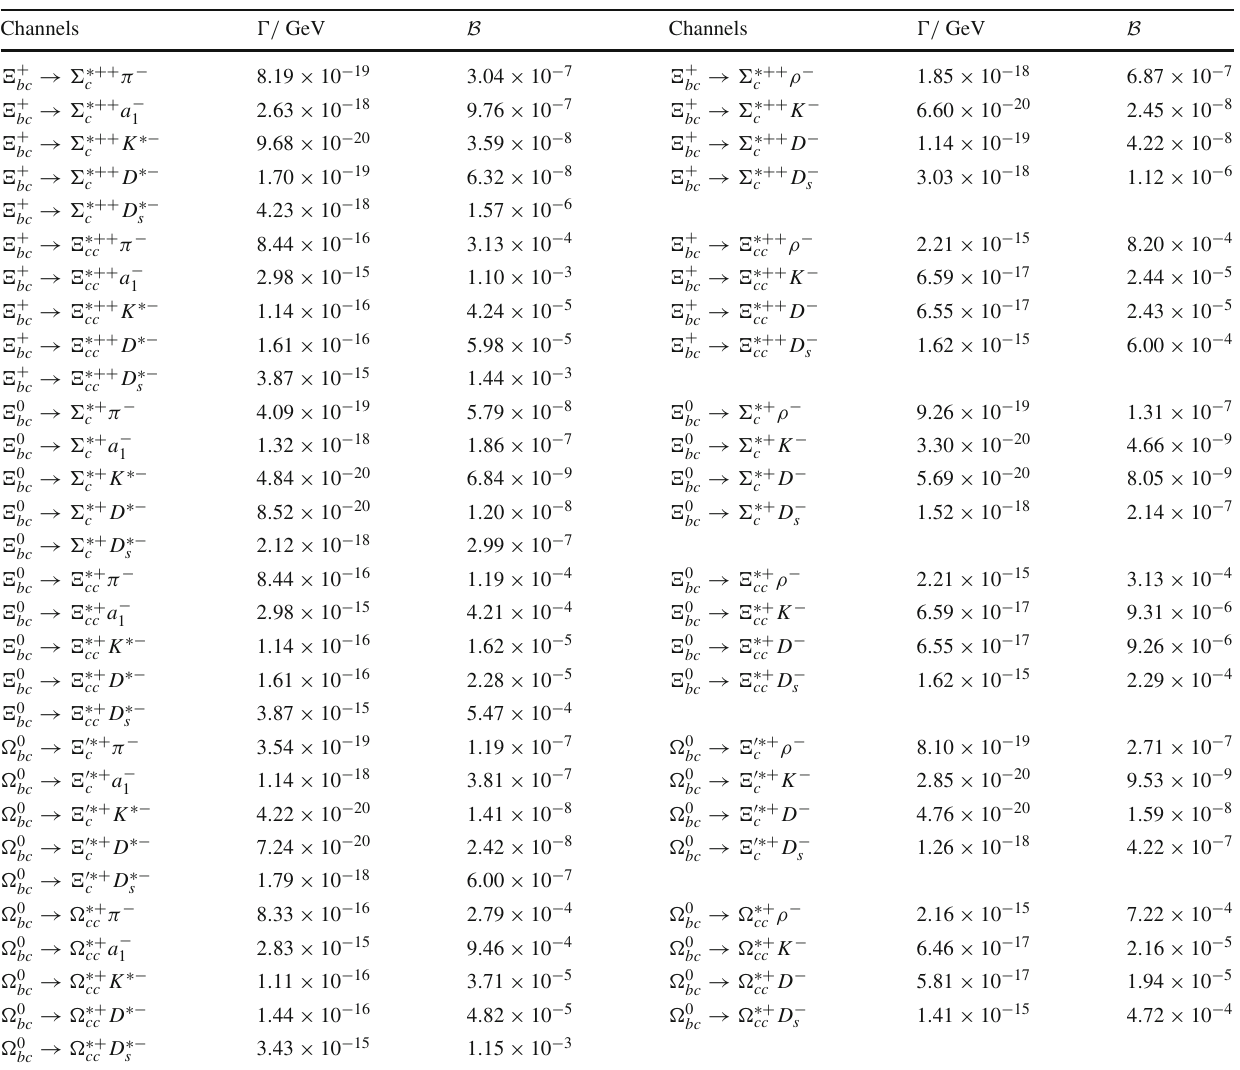
Table 19 Nonleptonic decays for the bc sector with b quark